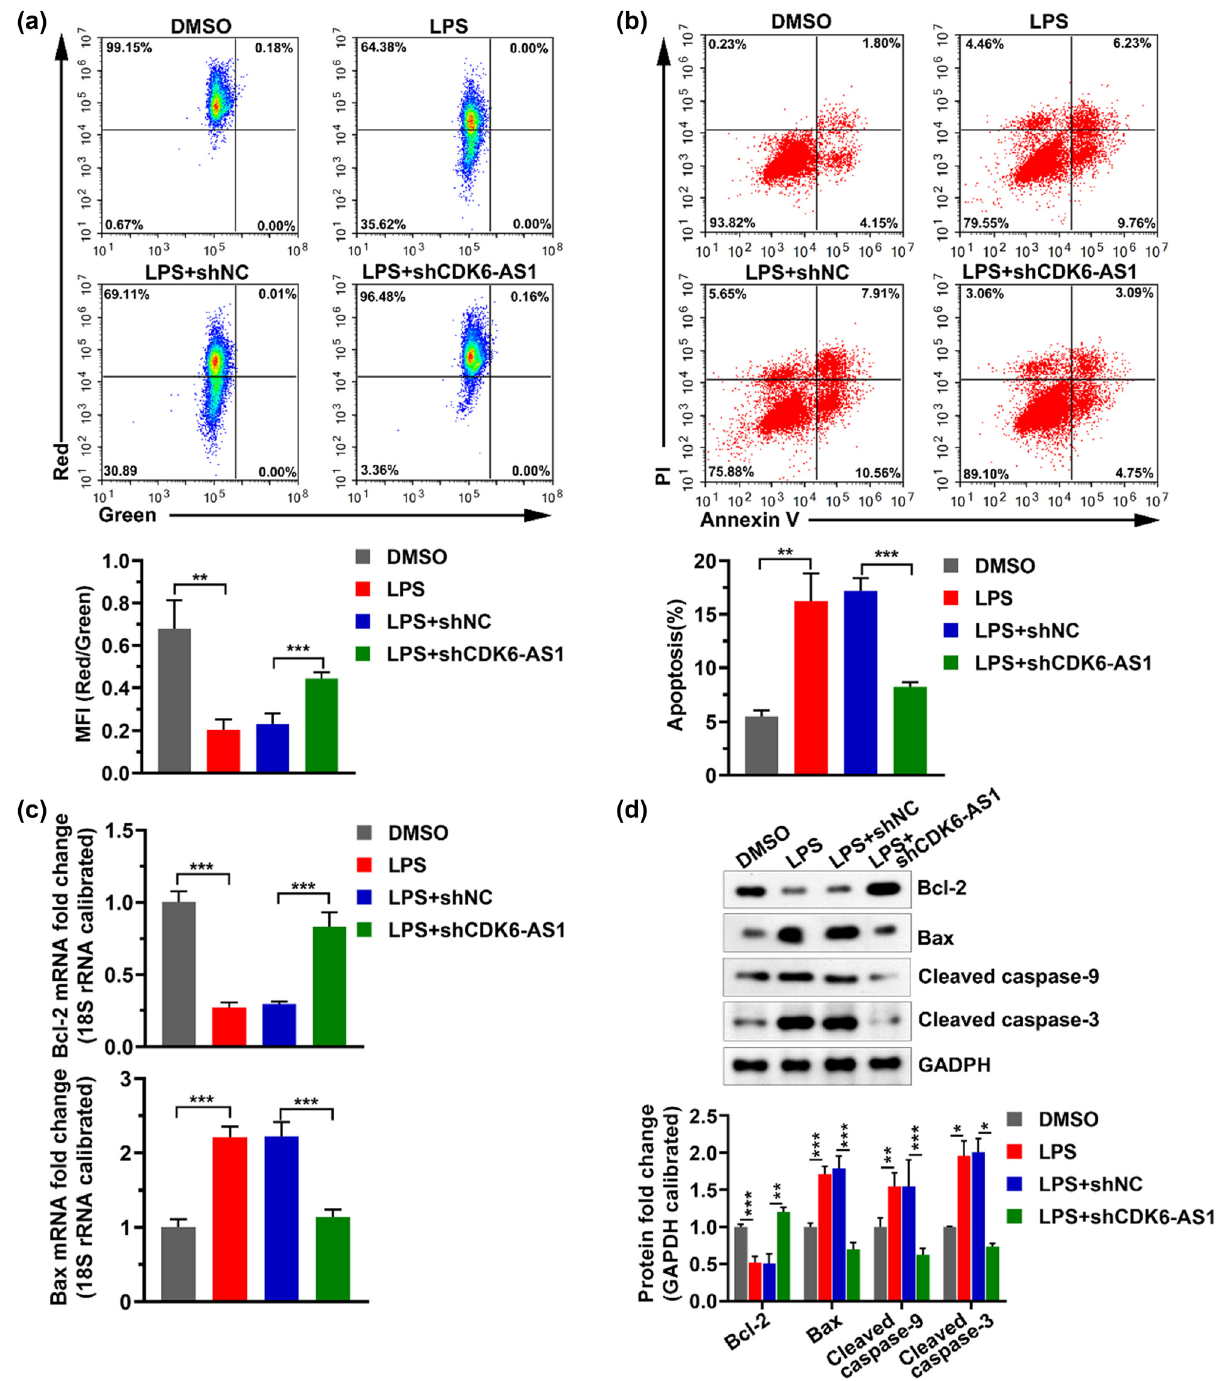
Figure 3: E ff ects of LPS and CDK6 - AS1 on apoptosis: ( a ) the representative image of mitochondrial membrane potential and the histogram of statistical mean fl uorescence intensity ( MFI ) , ( b ) the representative image of apoptosis and the histogram of apoptosis rate, ( c ) the mRNA levels of Bcl - 2 and Bax detected by qPCR, and ( d ) protein levels of Bcl - 2, Bax, cleaved caspase - 9, and cleaved caspase - 3 tested by western blotting. MFI: mean fl uorescence intensity. PI: propidium iodide. * P < 0.05, ** P < 0.01, *** P <